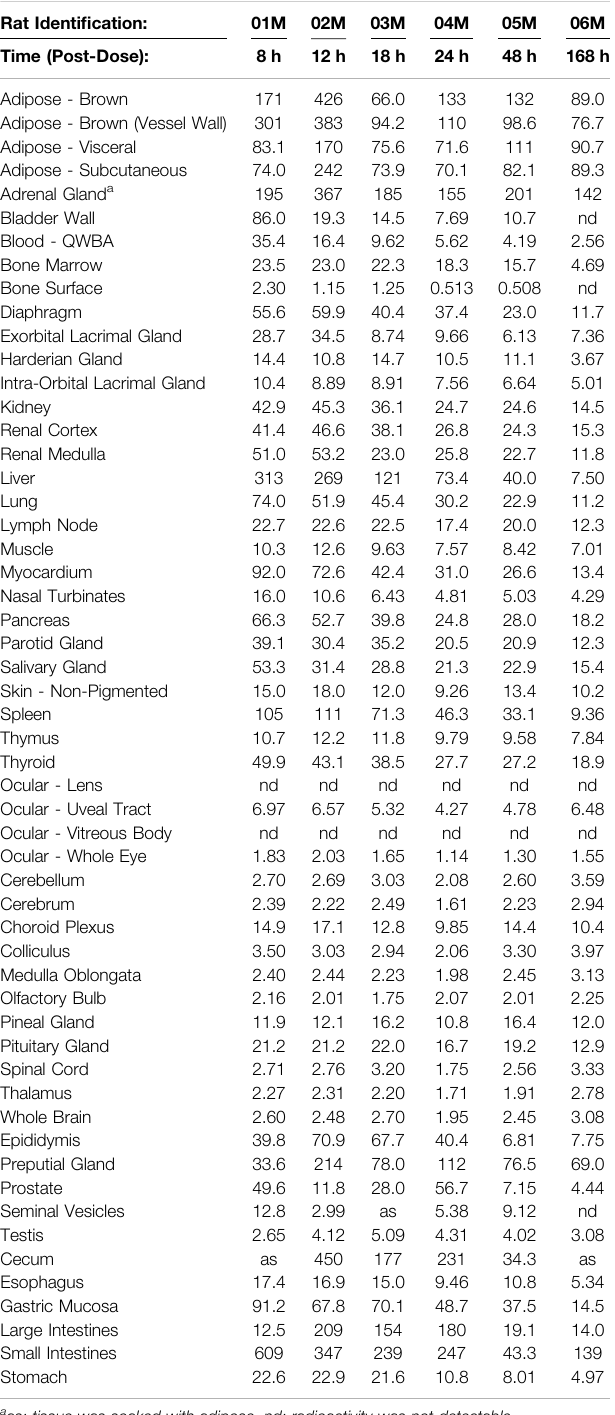
TABLE 2 | Radioactivity concentrations ( μ g equivalents/g) determined by quantitative whole-body autoradiography in tissues and blood through 168 h after a single oral dose of [ 14 C]PPI-1011 to Group 1 Sprague-Dawley male rats (Nominal Dose Levels: 200 μ Ci/kg and 100 mg/kg). Rat Identi fi